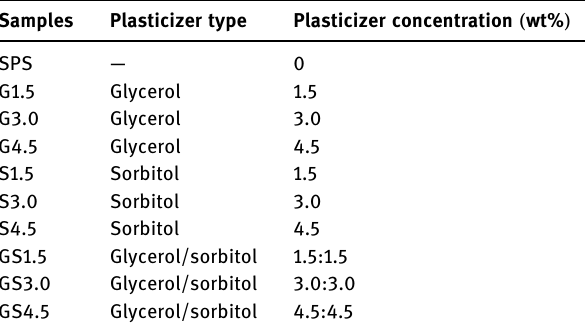
Table 1: Formulation of plasticizer used in the preparation of bio